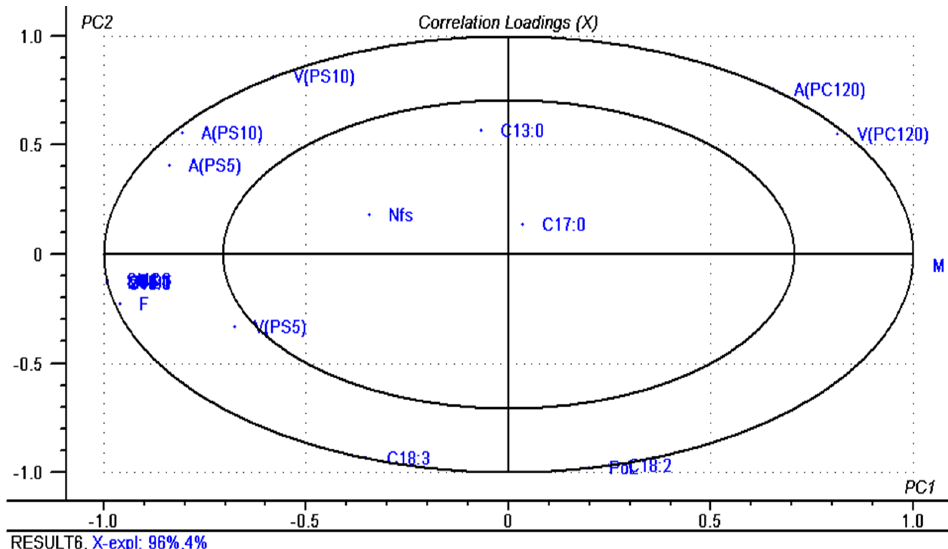
Figure 3. PCA loadings of butter samples.